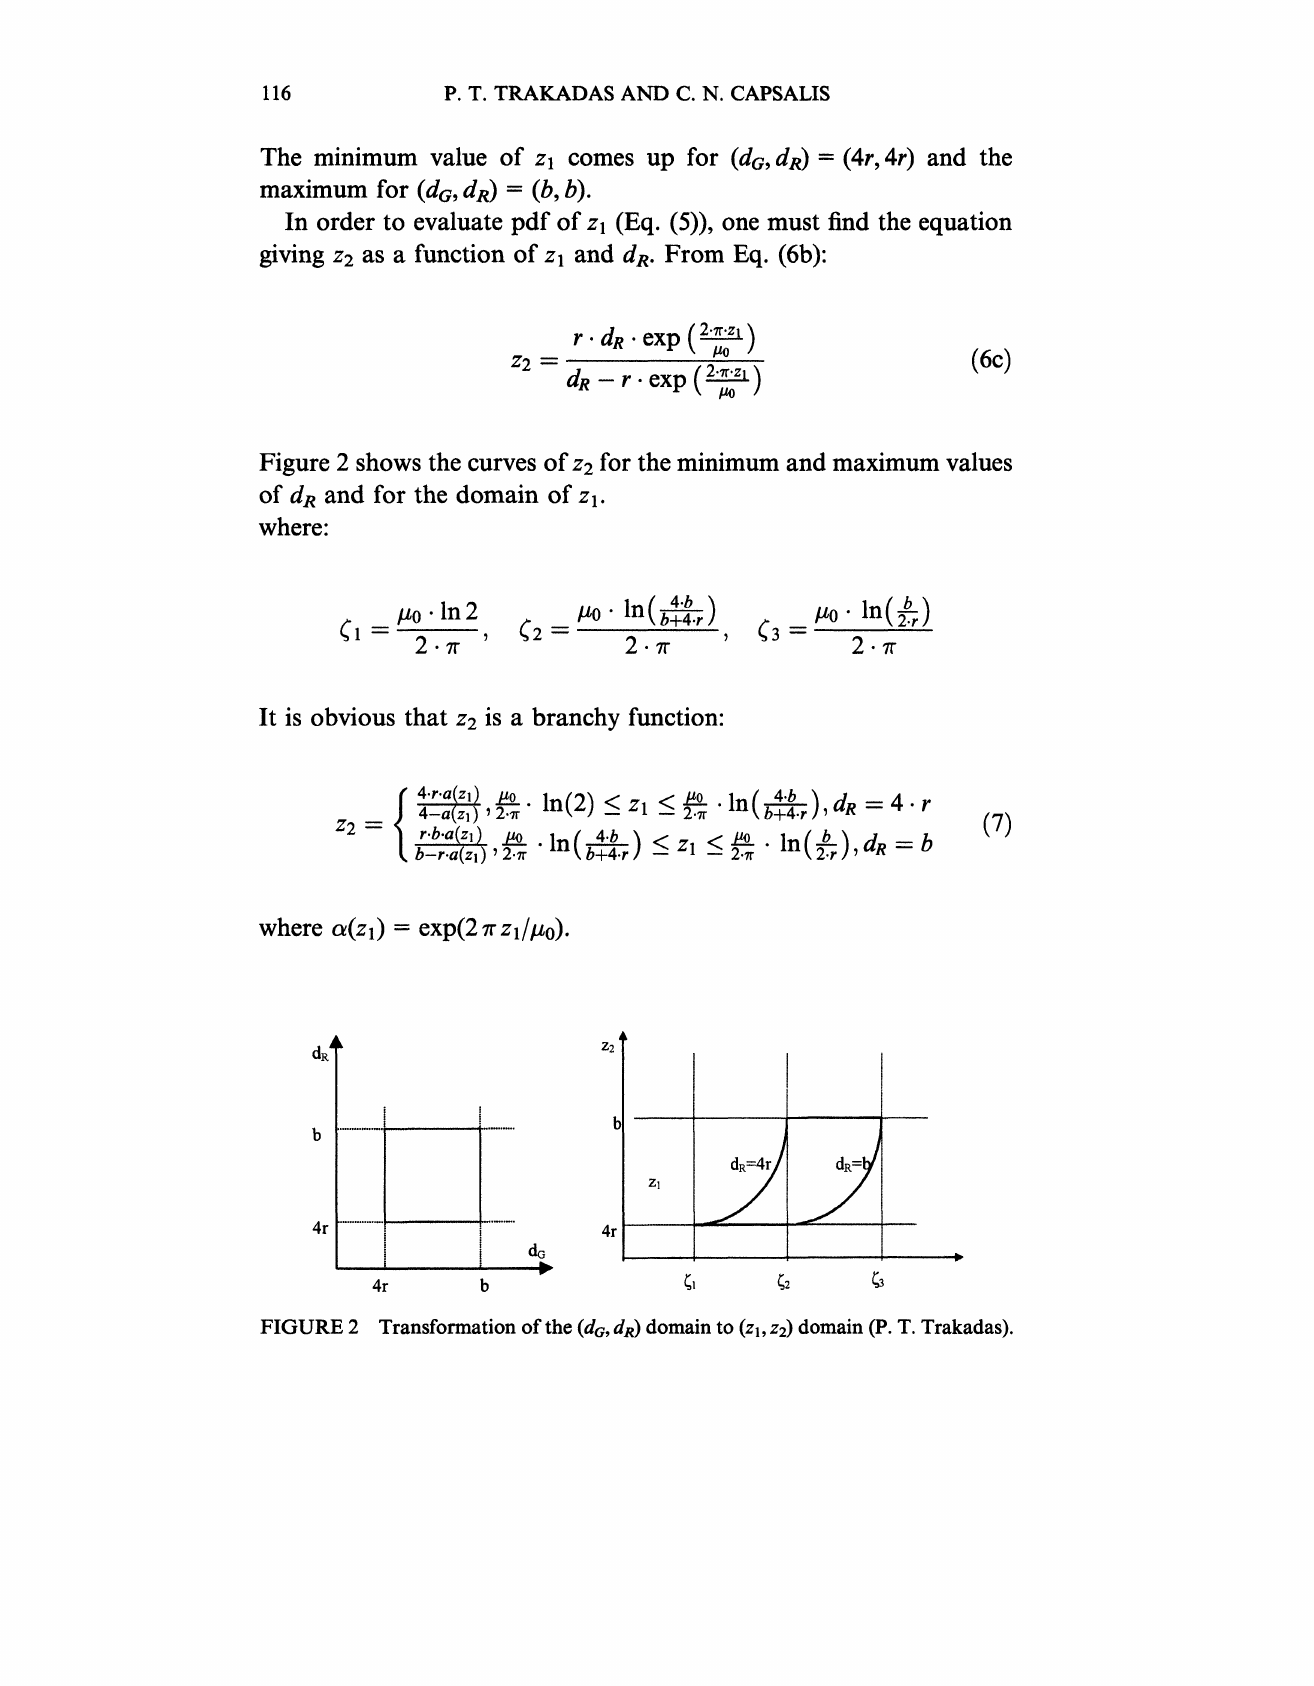
FIGURE 2 Transformation ofthe (de, dR) domain to (ZI,Z2) domain (P. T.